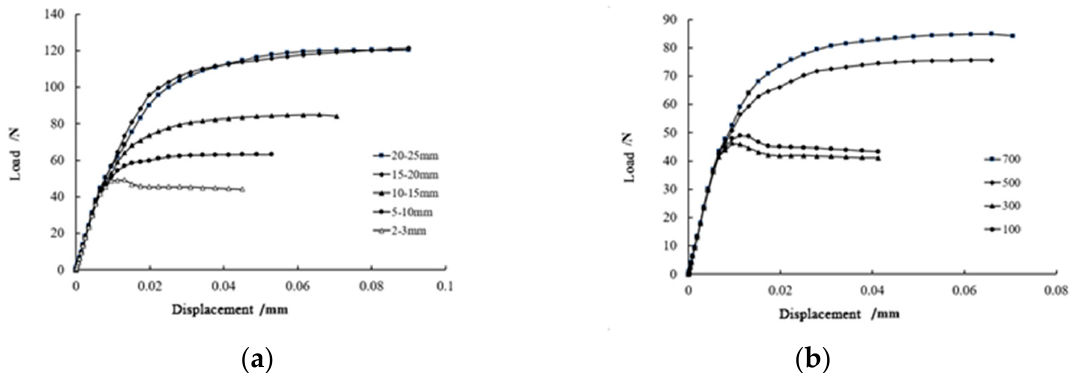
Figure 6. Load–displacement curves for concrete test group. ( a ) For different fiber lengths; ( b ) for different numbers of fibers.